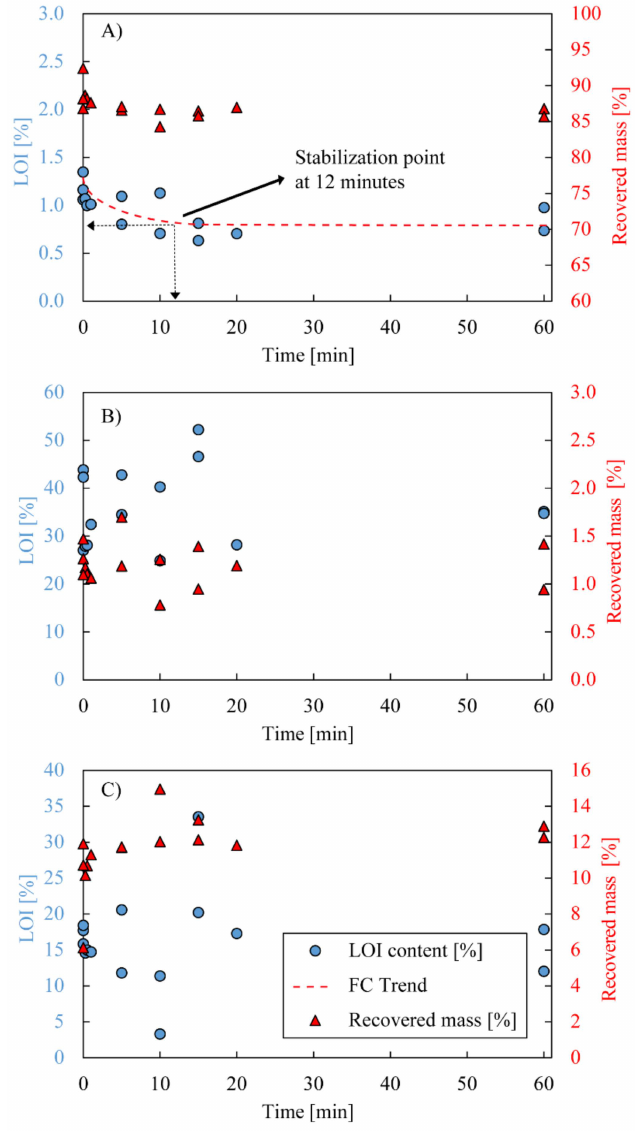
Figure 6. ( A ) Clean sands, ( B ) fines wasted material, ( C ) light wasted material. Sink and float concentrates near 12% of the initial mass, with no trend apparent through the observed time. The average LOI value is near 20% (Figure